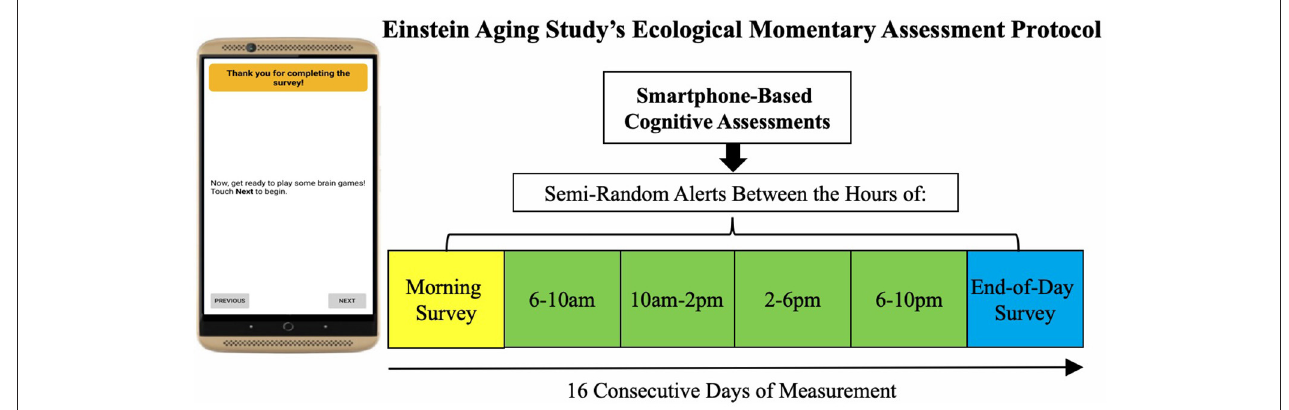
FIGURE 1 | Study design for EAS digital health